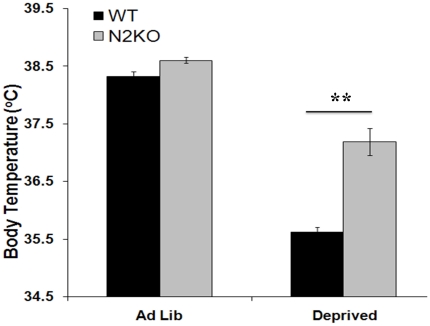
Core body temperature in ad lib fed and fasted WT and N2KO mice.Body temperature (°C) was measured using a rectal thermometer in WT and N2KO mice following ad libitum feeding (Ab lib) and following a 24-hour fast (Deprived). (**p≤0.01).